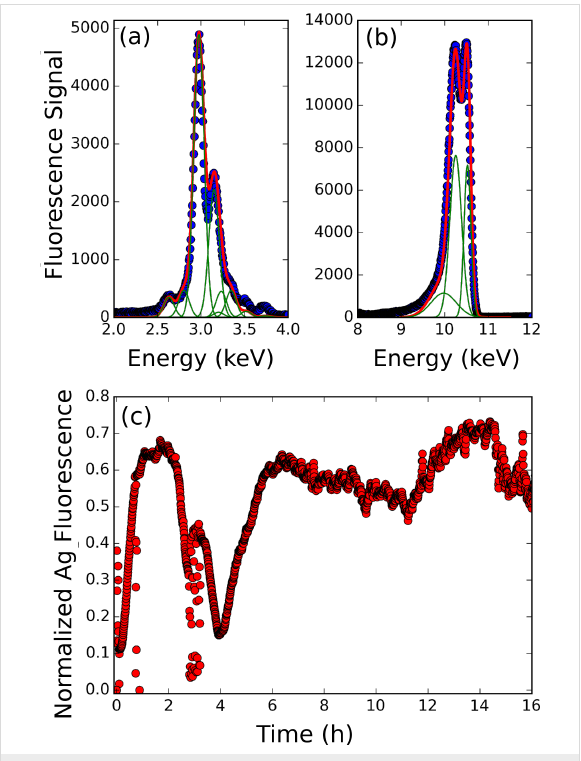
Figure 1: (a) X-ray fluorescence spectrum in the L-line energy range of Ag, where the green lines are the individual L line components, and the red is the fit by the sum of all lines. (b) Elastic and Compton peak analysis of the fluorescence spectrum. (c) Time evolution of the silver fluorescence intensity during 16 h of irradiation of a behenic acid Langmuir monolayer deposited on a silver sulphate aqueous solution. The signal is normalized by the elastic peak